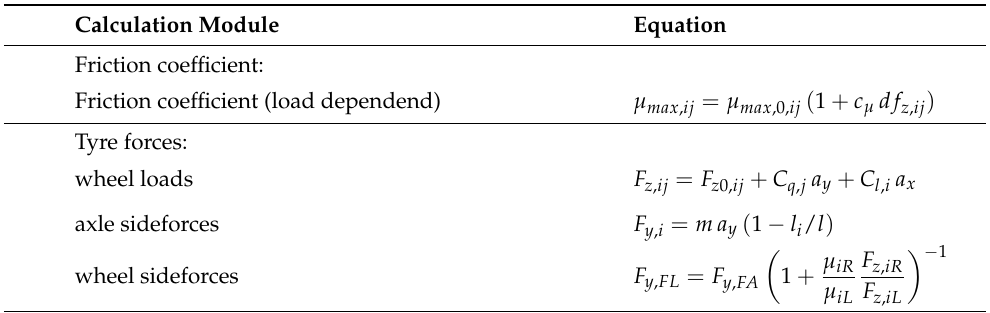
Table 2. Basic equations from the patent application [23,25] “Method for distributing a requested torque“ including the extensions for the